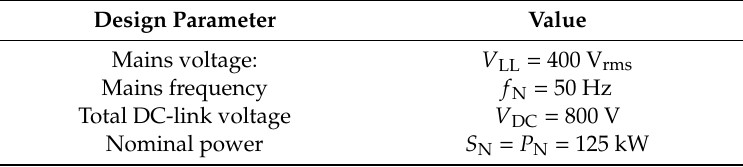
Table 1. System-level design specification of the three-phase converter (nominal